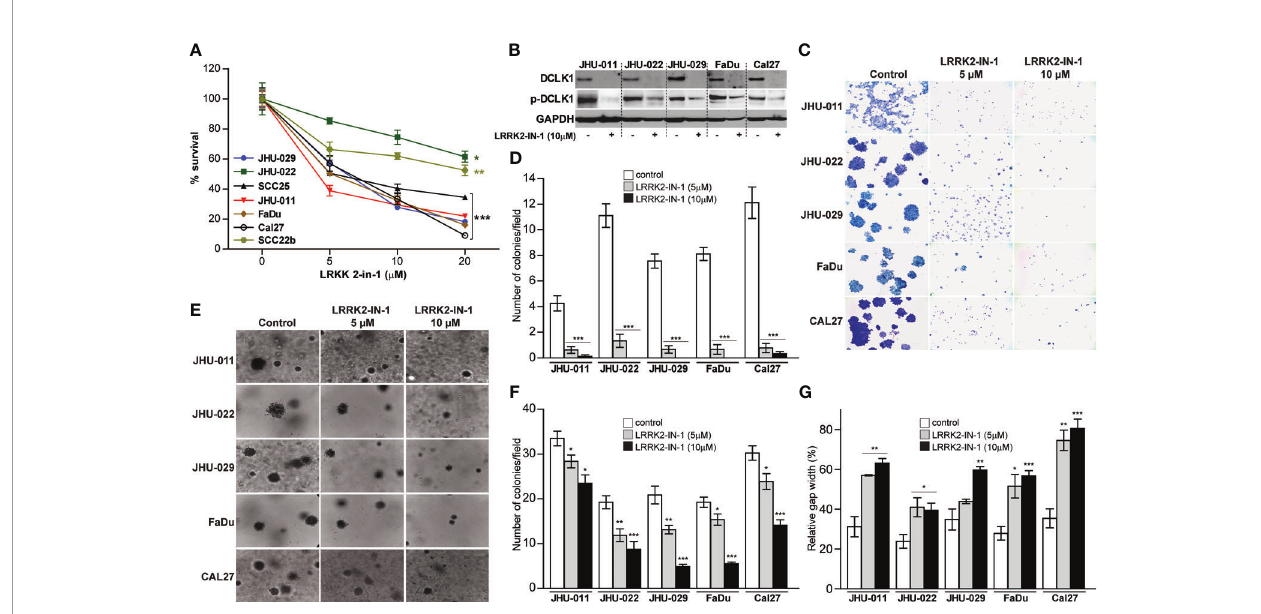
FIGURE 1 | Pharmacologic inhibition of DCLK1 leads to reduced proliferation, migration, in fi ltration, colony formation and anchorage independent growth. (A) Seven HNSCC cell lines were treated with either indicated concentrations of LRRK2-IN-1 or DMSO (solvent) for 72 hours. Relative cell viability was determined using an Alamar Blue assay (*p < 0.05, **p < 0.01 and ***p < 0.001). (B) Cell lysates were collected at end point from cells treated with 10 m M DCLK1 and control cells and analyzed by western blot for the expression of indicated proteins. GAPDH was used a loading control. (C, D) Colony formation assay: cells were treated with LRRK2-IN-1 or vehicle for 14 days. Representative images (C) and quanti fi cation (D) of LRRK2-IN-1 mediated reduction of colony formation in HNSCC cell lines are shown. (E, F) Soft agar anchorage-independent growth: cells were treated with LRRK2-IN-1 or vehicle for 14 days. Representative images (E) and quanti fi cation (F) of LRRK2-IN-1 mediated decrease of anchorage-independent growth of HNSCC cells are shown. (G) Indicated HNSCC cell lines were treated with 10 m M LRRK2-IN-1 or DMSO for 72 hours. Cells were trypsinized, counted, plated in triplicate in 6-well plates (1 x 10 6 cells per well) containing inserts and allowed to attach for 12 h. The inserts were removed and the gap was photographed immediately and after 12 h. Gap area in individual wells was measured using ImageJ and relative gap width percentage was calculated as the gap area at 12 h relative to the gap area at 0 h (*p < 0.05, **p < 0.01 and ***p <